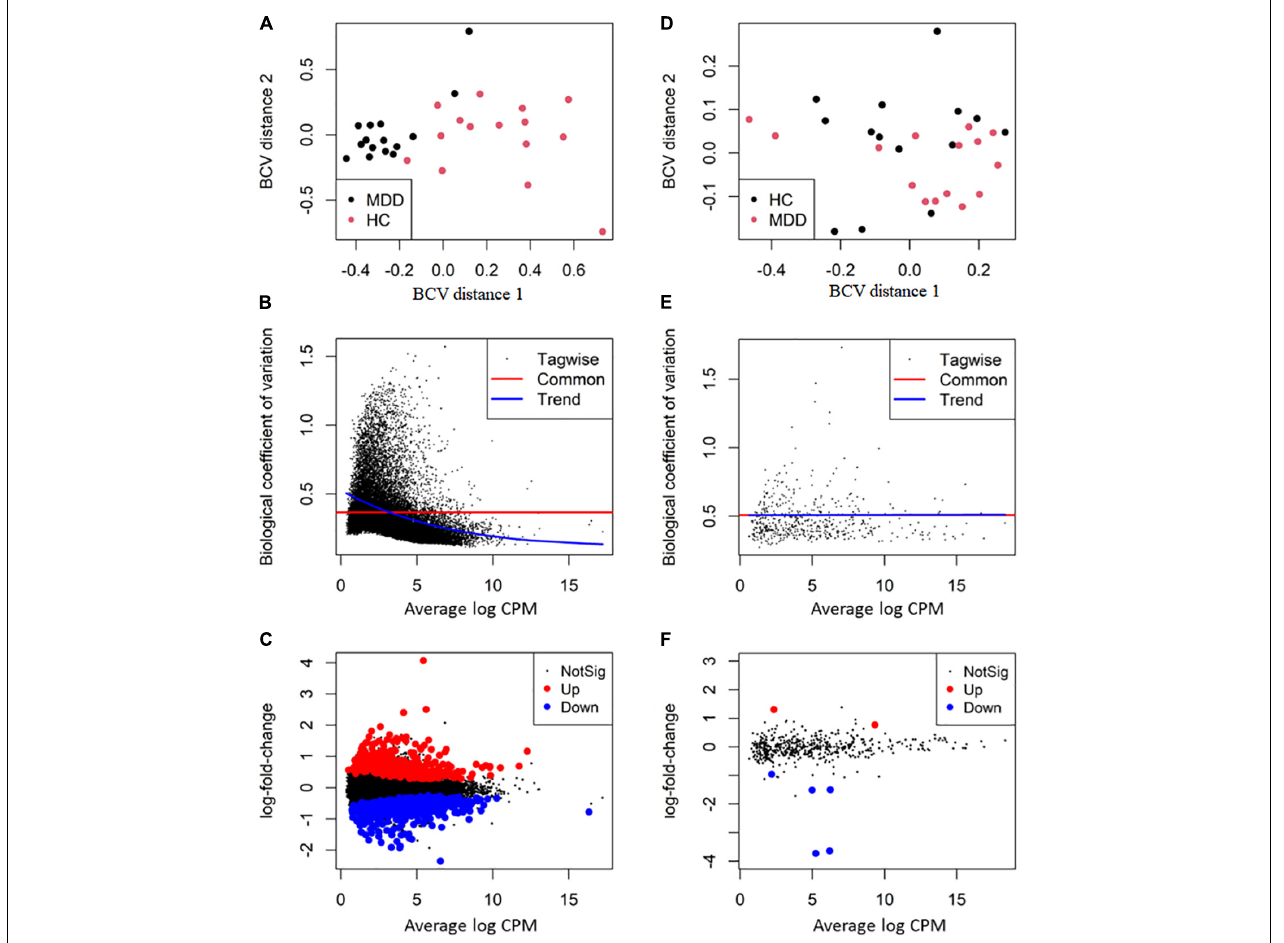
FIGURE 2 | Differential expression analysis of RNA transcripts. The RNA package EdgeR was employed for differential expression analysis of RNA transcripts between major depressive disorder (MDD) and healthy controls (HCs). (A,D) The plot of biological coefficient of variation (BCV) distance of all the samples for RNA sequencing and small RNA sequencing, respectively; (B,E) the BCV plot of dispersion estimates for RNA sequencing and small RNA sequencing, respectively; (C,F) plots of log-fold change against log-counts per million for RNA sequencing and small RNA sequencing, respectively. The differentially expressed RNAs are